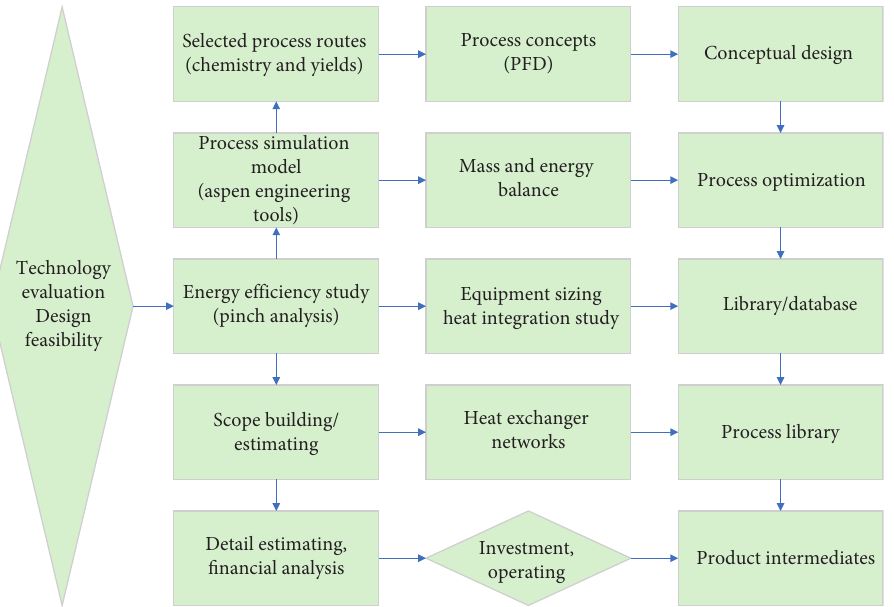
Figure 4: Evaluation of the metric design